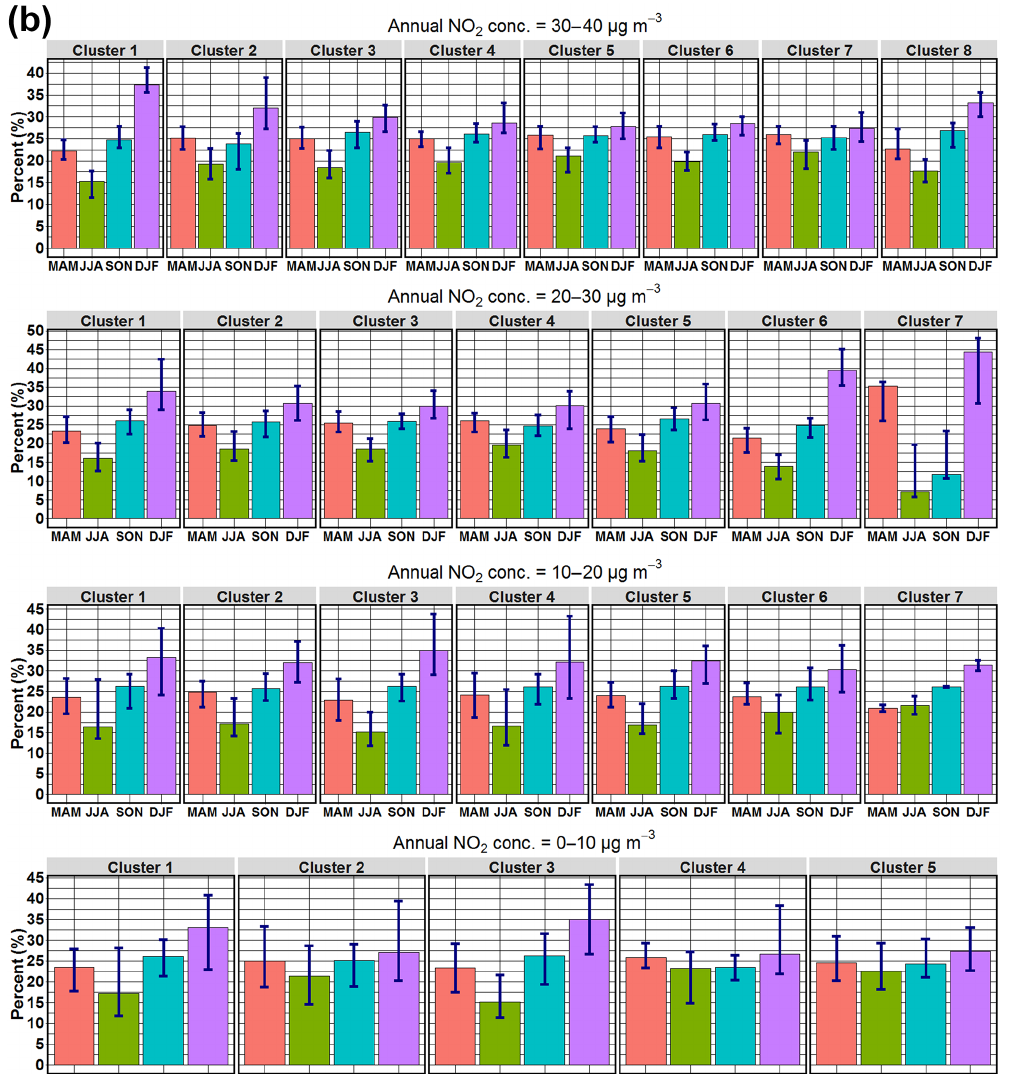
Figure 4. The contribution to 2010–2014 average annual NO 2 concentrations (NO 2AA ) from spring (March, April, and May), summer (June, July, and August), autumn (September, October, and November), and winter (December, January, and February) months for sites with 2010–2014 NO 2AA concentrations for sites between (a) 40 and >80µgm − 3 and between (b) 0 and 40µgm − 3 , split into 10µgm − 3 bins based on the magnitude of the 2010–2014 NO 2AA concentration. For the >80 and 70–80µgm − 3 bins, these contributions are shown for sites individually (identified by Airbase ID), while for lower concentration bins sites are grouped into clusters with distinct variation in monthly, hour of day, and hourly concentration contribution to NO 2AA . For these bins, the height of the bar shows the median contribution to 2010–2014 NO 2AA from that season across all sites, with the 5th and 95th percentile values across the sites shown as uncertainty bars.